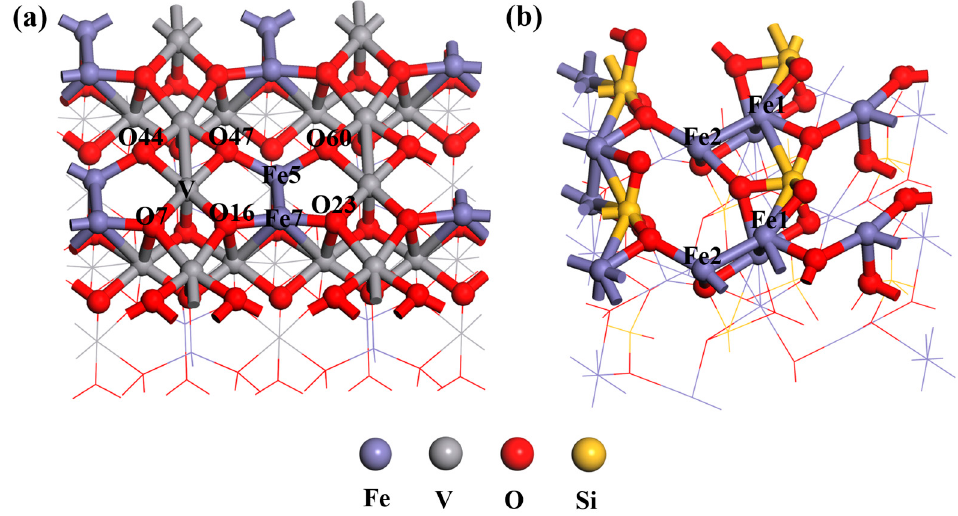
Figure 1. ( a ) FeV 2 O 4 (001) Fe-terminated surface, ( b ) Fe 2 SiO 4 (010) surface. Table 2. Bond order of Fe-O bond and V-O bond in FeV 2 O 4 (001) Fe-terminated surface. Bond